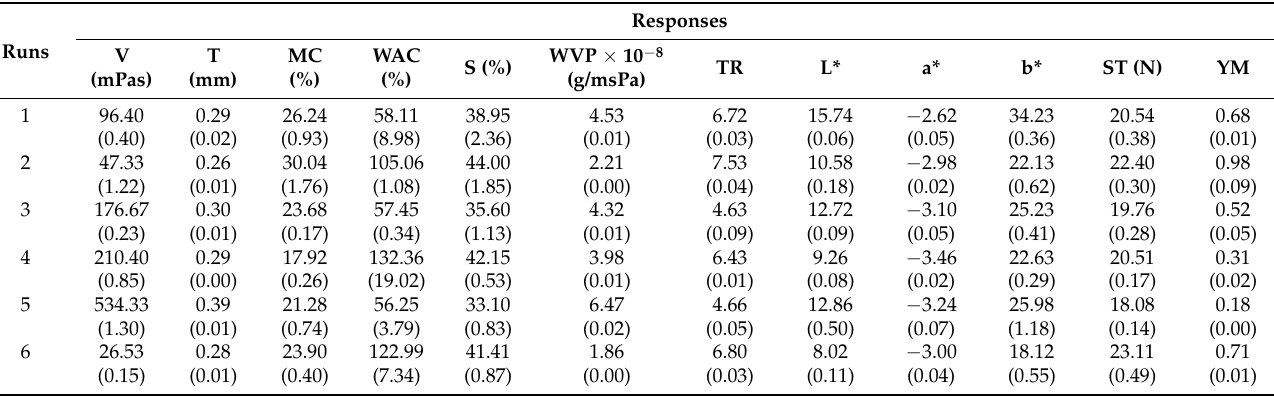
Table 2. Box–Behnken experimental design with independent variables (un-coded) and observed values of response